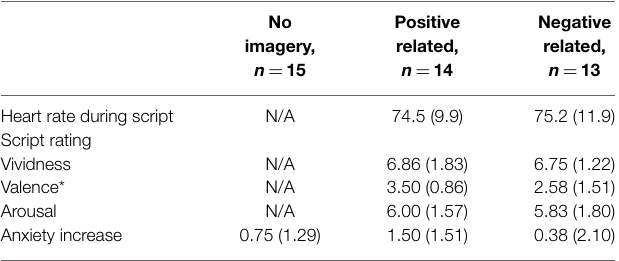
TABLE 2 | Heart rate during scripted imagery, script ratings, and subjective anxiety in Experiment 2 ( n = 42) .